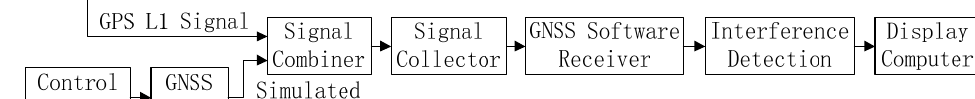
Figure 8. The experimental platform of the GNSS interference detection test.